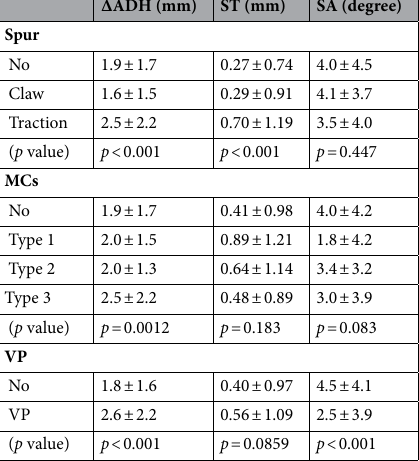
Crude analysis Adjusted analysis